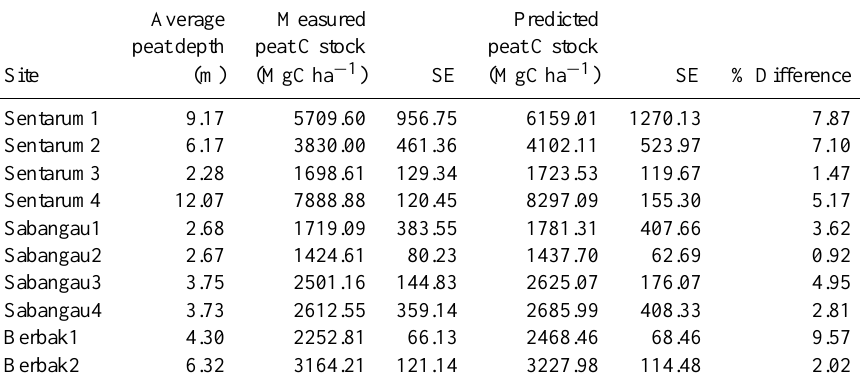
Table 4. Comparisons of peat carbon stock estimates using measured C d and predicted C d using Eq. (1). Estimates are for ten sites across three national parks of